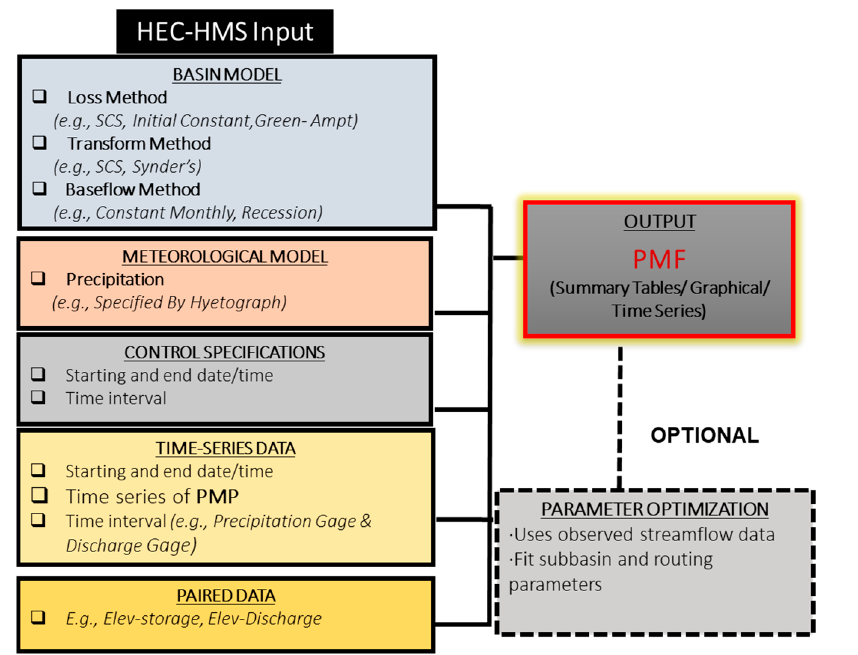
Figure 4. HEC-HMS Input.